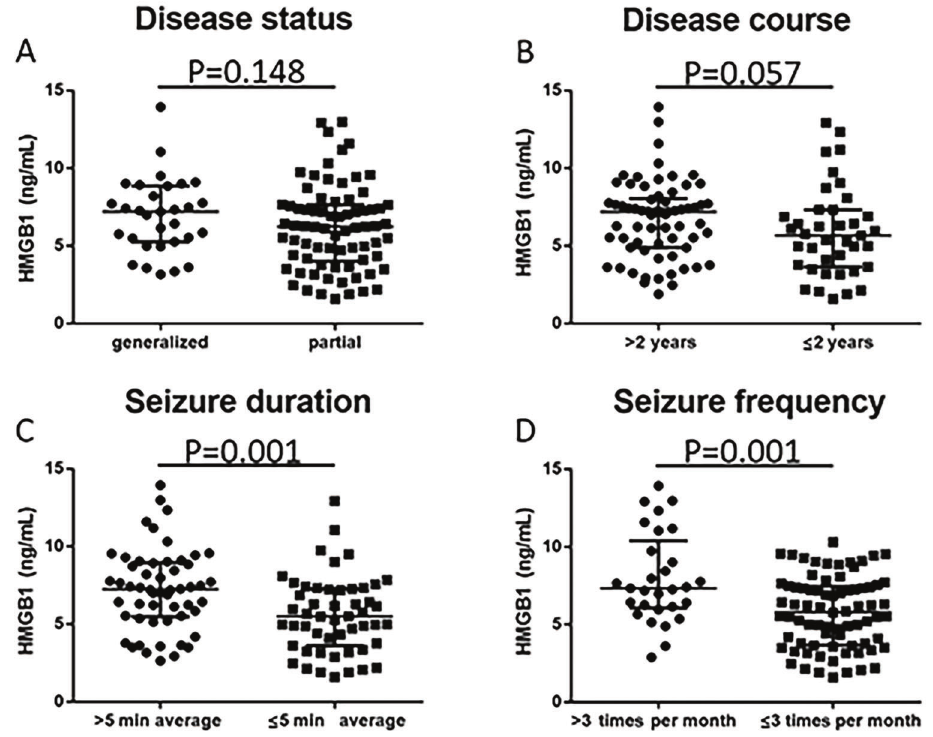
Figure 4. Comparison of high-mobility group box-1 (HMGB1) between subgroups in epilepsy patients using the Mann-Whitney test. A , Disease status; B , disease course; C , seizure duration; D , seizure